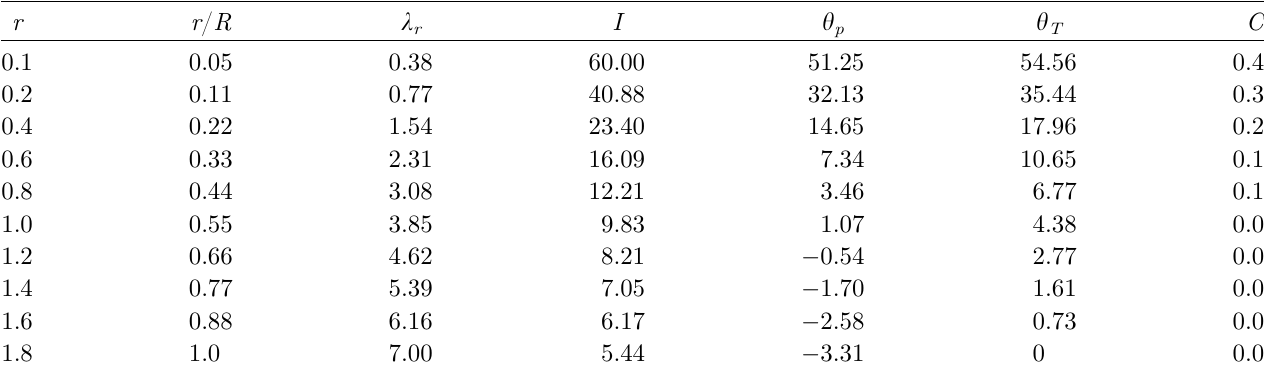
Table 1. Variation in WT-blade parameter without taking wake into consideration.